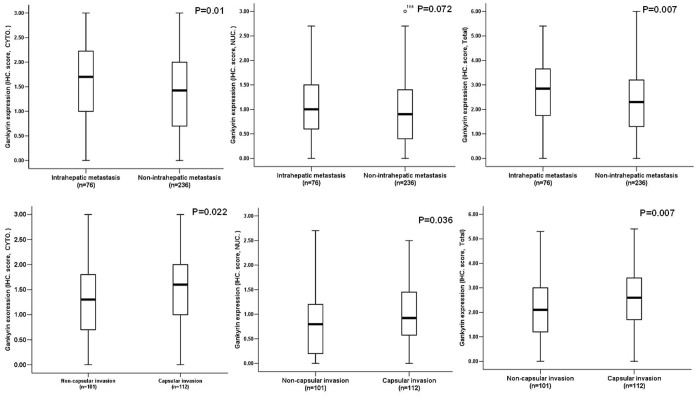
The intratumoral overexpression of Gankyrin scored at the cytoplasmic, nuclear, and total cellular levels was statistically correlated with capsular invasion and intrahepatic metastasis in HCC patients.